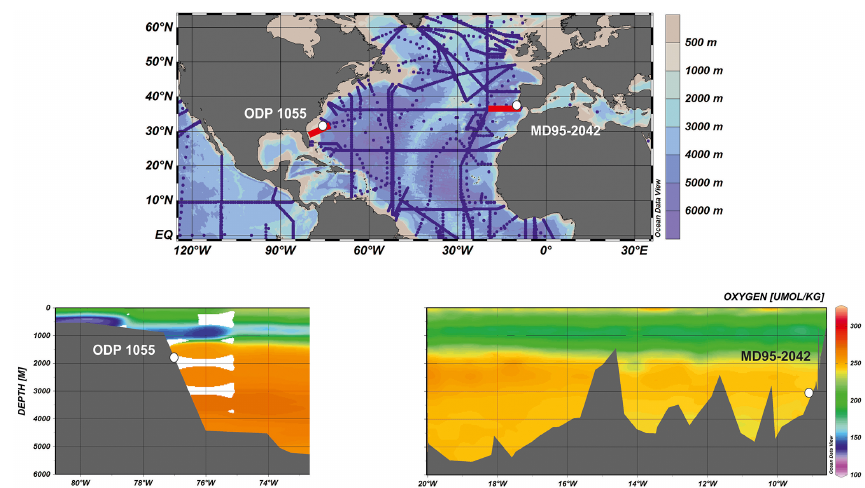
Figure 1. Locations of the two cores (ODP 1055, MD95-2042) used in this study projected on a global bathymetric map (top panel). The red sections show the locations of the two sea water [O 2 ] profiles shown in the bottom panel. [O 2 ] profiles were made using GLODAP version 1.1 bottle data (Key et al., 2004). Cross sections and map were created using Ocean Data View (Schlitzer, R., Ocean Data View, http://odv.awi.de,